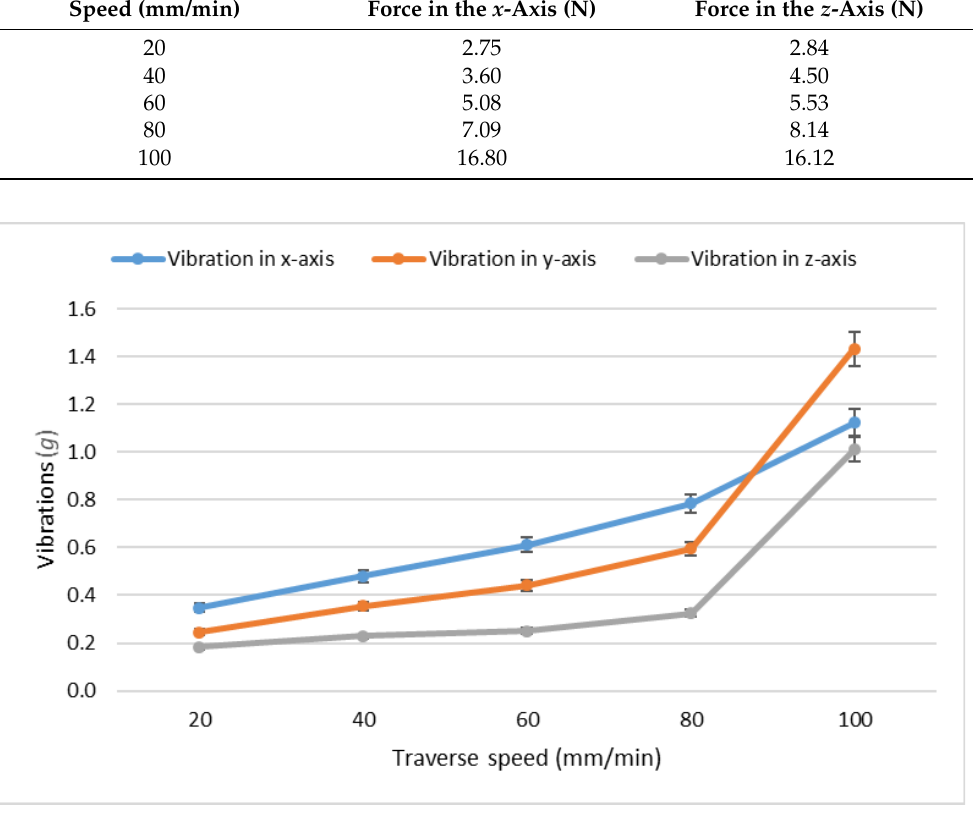
Figure 7. Measured vibrations in relation to the traverse speed on the steel 1.2379.